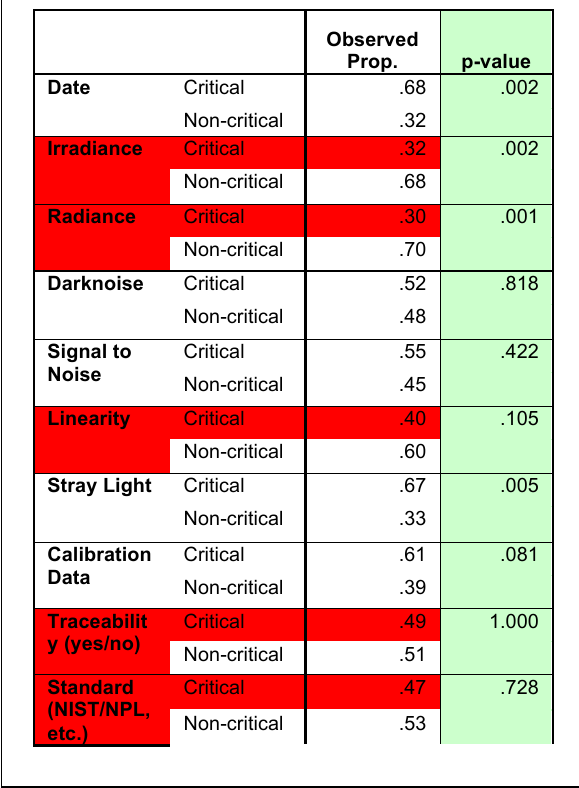
Table 3.1 Binomial test results for ‘calibration’ metadata ( n=78